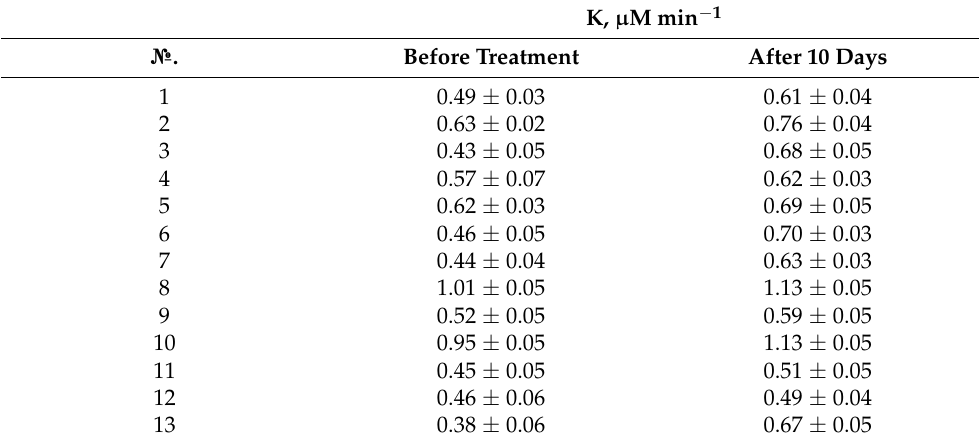
Table 2. The values of the total activity of antioxidants in the blood serum of patients with chronic cerebral ischemia ( p = 0.95, n = 3) when taking Mexidol (parenteral administration). K, µ M min − 1 № . Before Treatment After 10 Days 1 0.49 ± 0.03